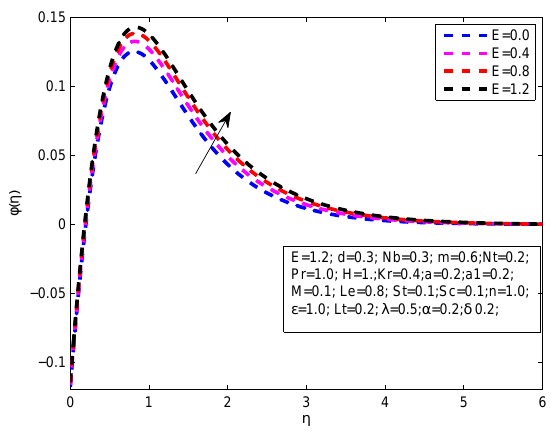
Figure 13. Variation of φ for distinct values of E